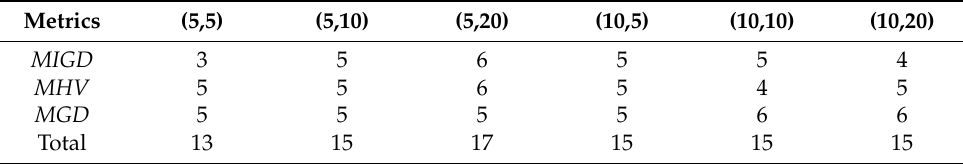
Table 5. The statistical results of six parameters on different